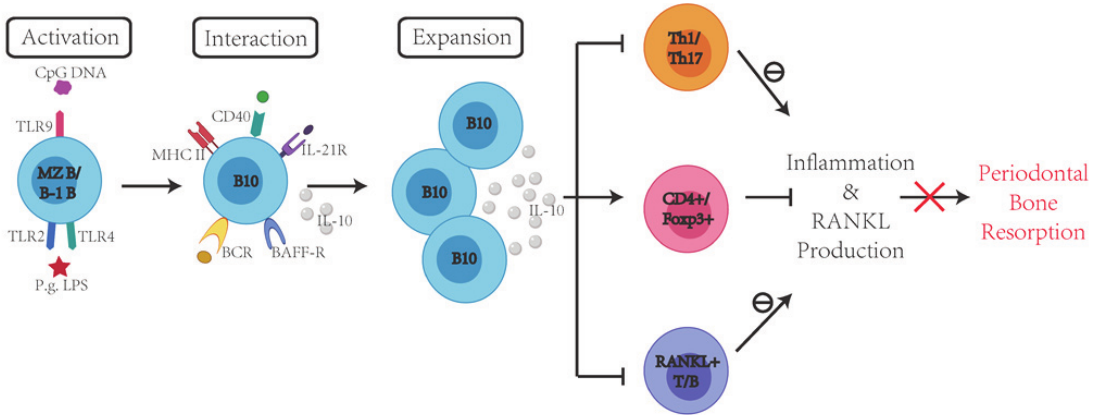
Figure 3. Promoting local B10 function to curtail immune-mediated periodontal inflammation and bone loss. In periodontal disease, activated Th1 and Th17 cells produce pro-inflammatory cytokines that contribute to tissue damage. Both activated T and B cells produce RANKL, which leads to osteoclast activation and alveolar bone resorption. B10 cell activation and expansion promote IL-10 secretion and promote CD4 + FOXP3 + Treg activation, inhibit Th1 / Th17 cells and RANKL + T / B cells activation, which inhibit inflammation and RANKL production, eventually alleviating periodontal bone resorption.